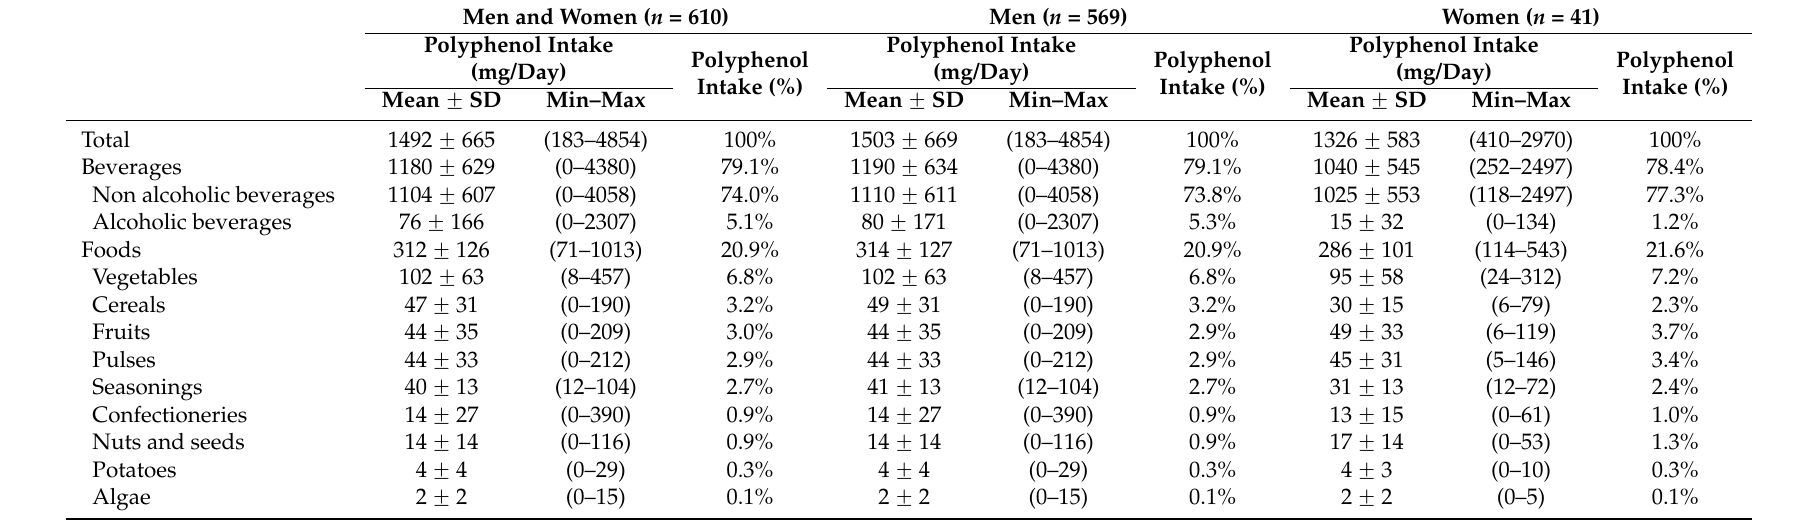
Table 2. The subjects’ polyphenol intake from beverages and